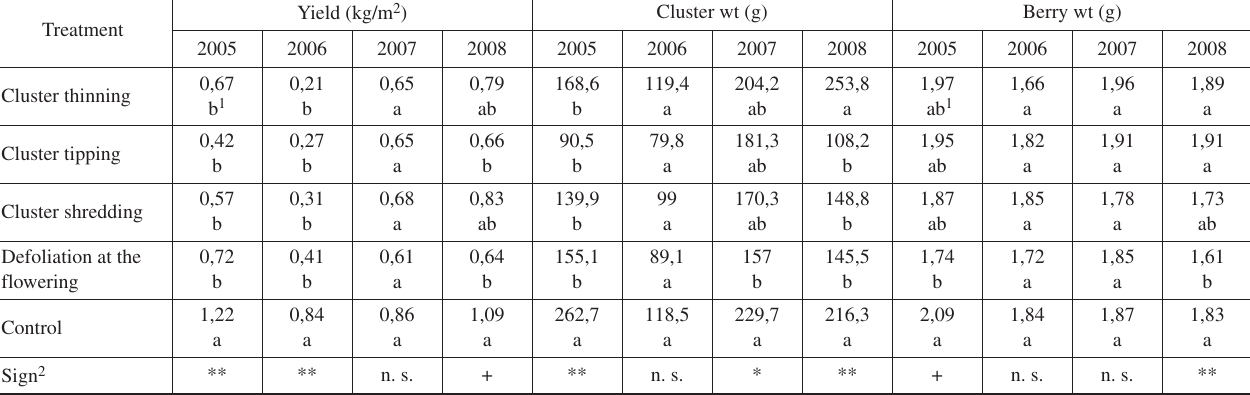
1 Means within columns followed by different letters differ significantly at p<0,05. 2 +, *, **, ns: significant at p<0,10, 0,05; 0,01, or not significant, respectively.